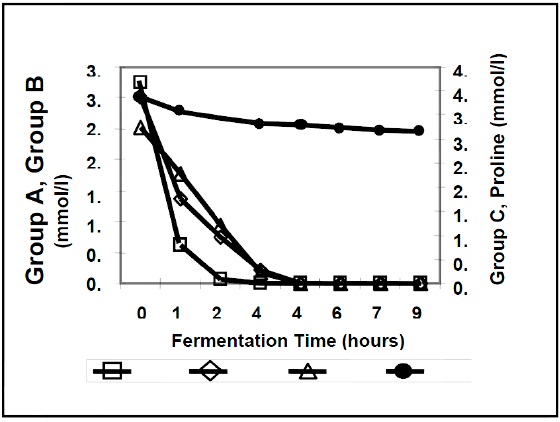
Figure 4. Amino acid absorption pattern during wort fermentation [40,41]. Fermentation 2017 , 3 , 63